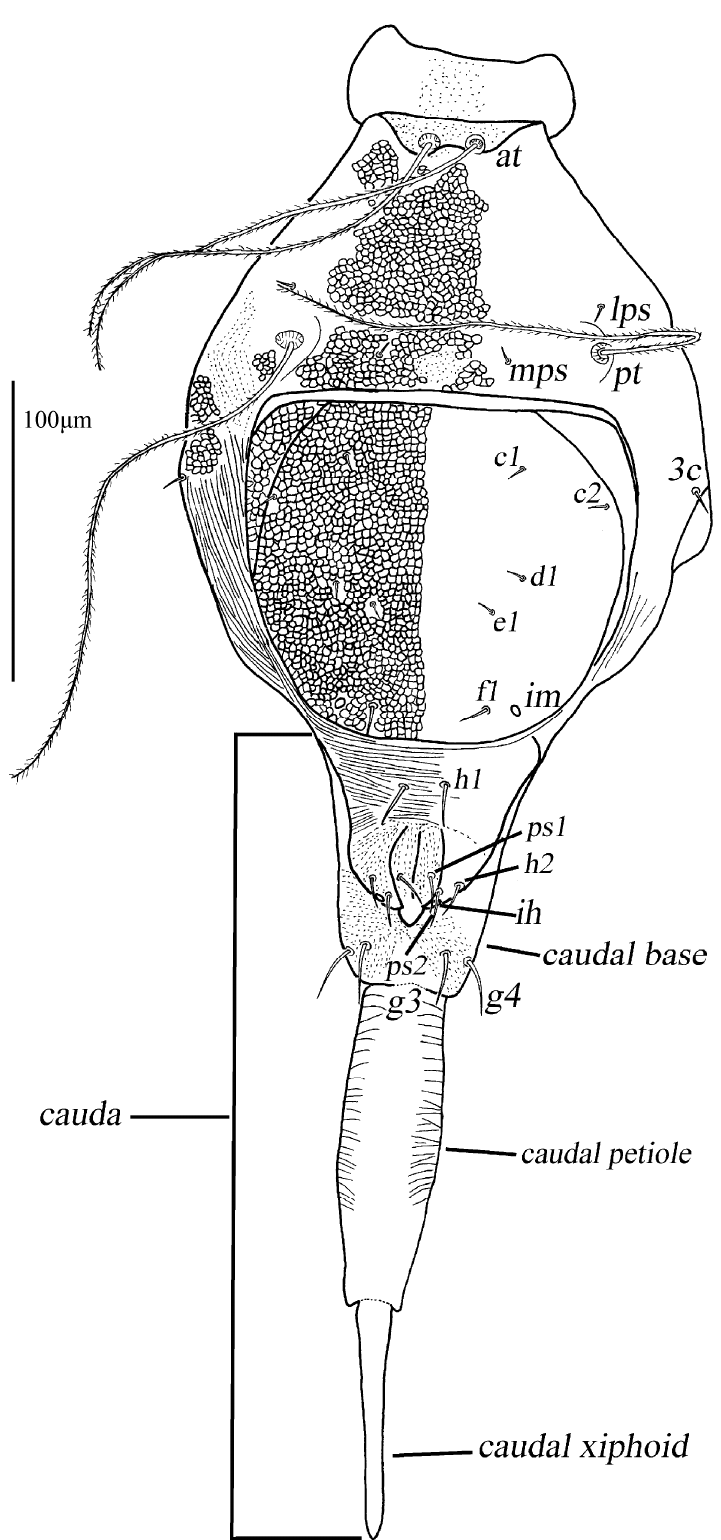
Figure 2. Cunaxicaudus mohanensis sp. nov. (male). Dorsal idiosoma. Scale bar = 100 µm.